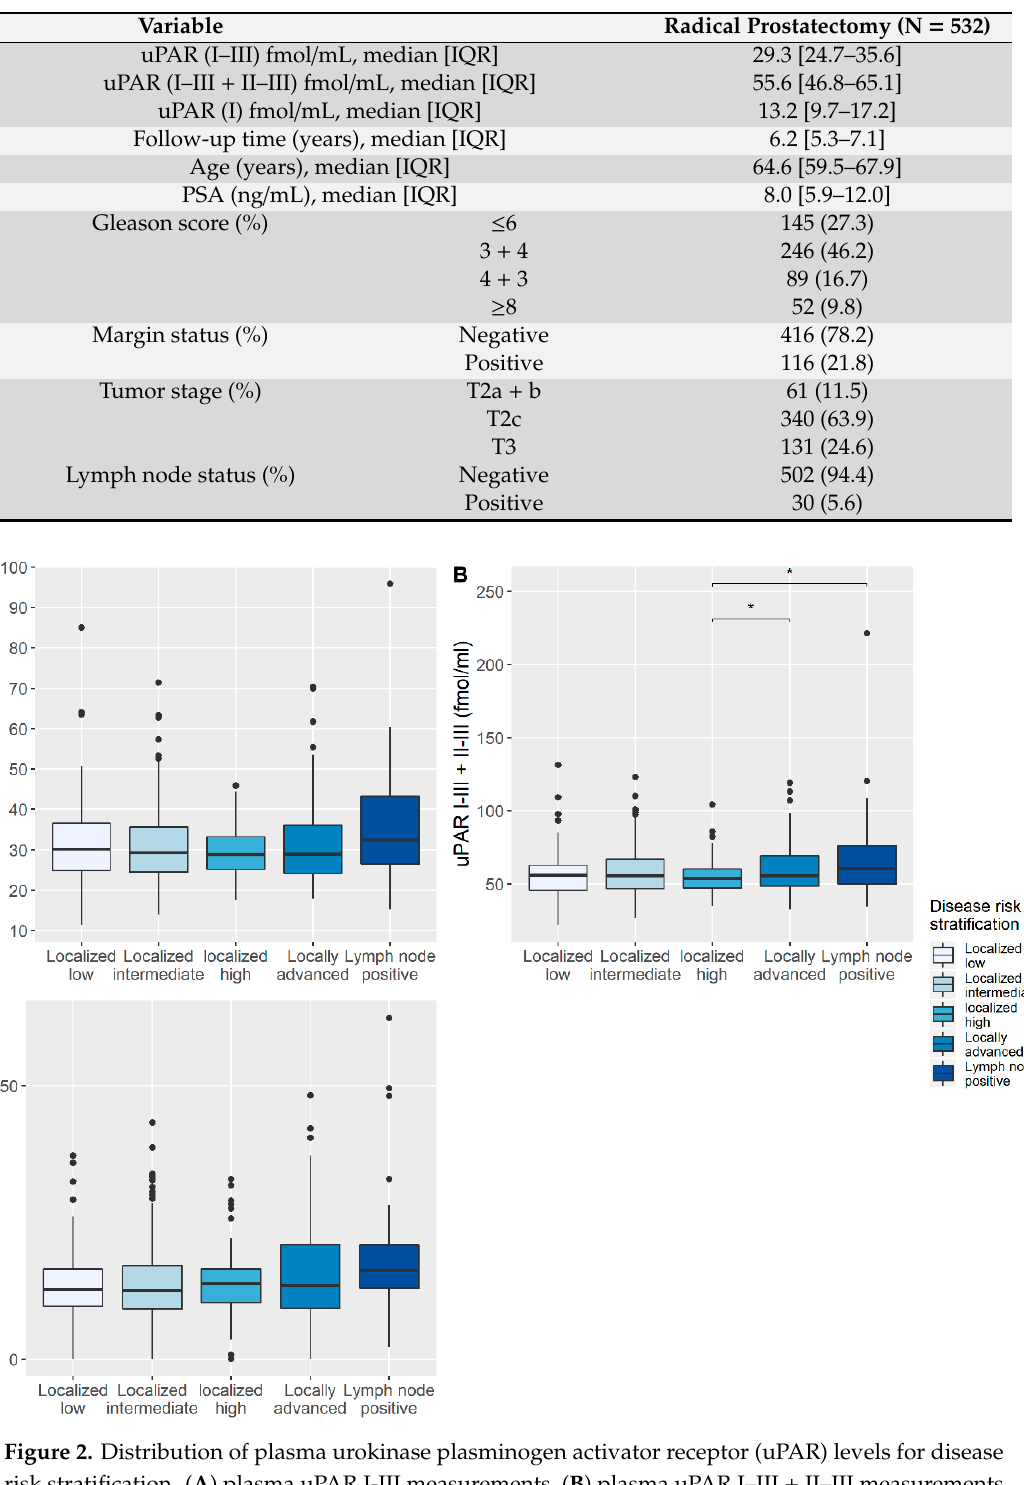
Table 1. Overall patient characteristics for patients receiving radical prostatectomy for prostate cancer.